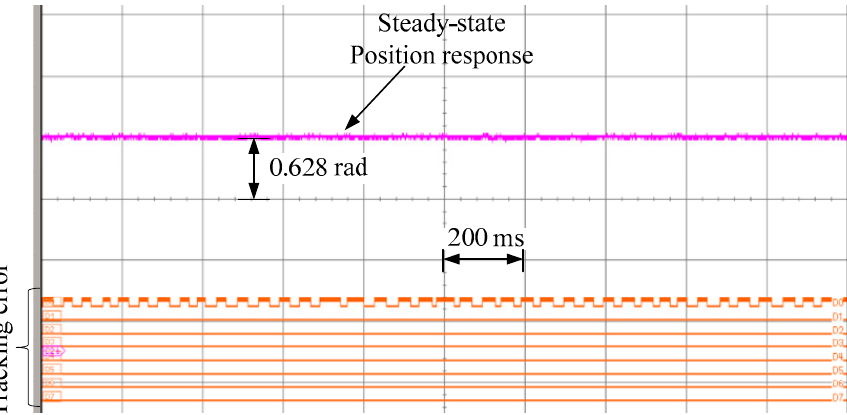
Figure 19. The experimental position steady-state error without load.